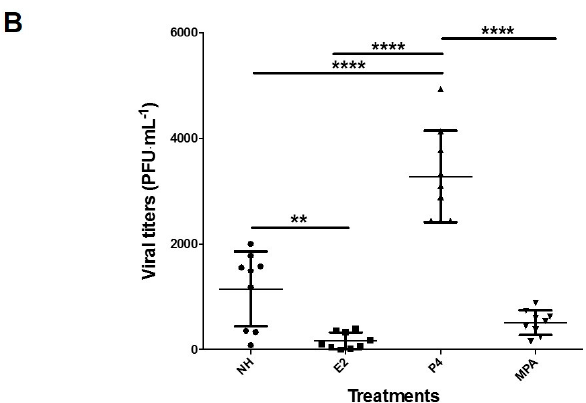
Figure 5. Difference in HSV-2 virus shedding by Vk2 cells in ALI and LLI conditions, exposed to different female sex hormones and MPA. To measure the viral shedding in Vk2 cell supernatants, Vk2 cells were exposed to 10 4 PFU of wild-type HSV-2 for 2 h in both LLI ( A ) and ALI ( B ). Apical supernatants were collected and shed virus was measured by plaque assay on Vero cells (PFU/mL). Data were pooled from three separate experiments and are shown as mean ± SEM. * p < 0.05, ** p < 0.01, **** p <